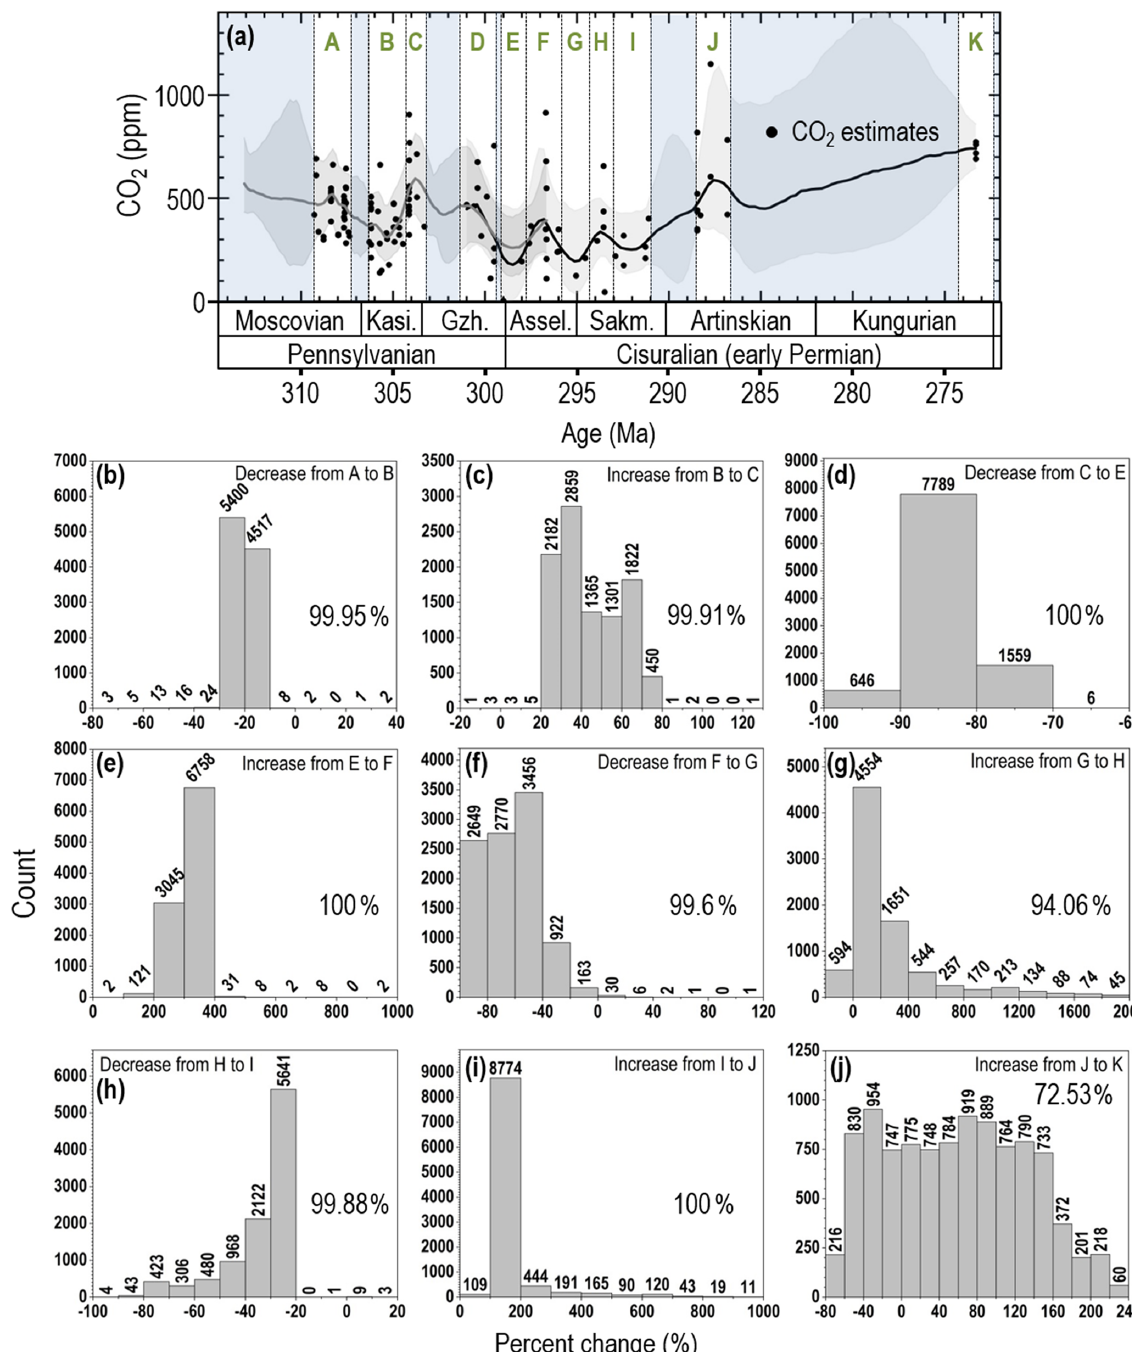
Figure 4. Analysis of the statistical significance of short-term CO 2 fluctuations. (a) White intervals (A–K) delineate short-term highs or lows in the CO 2 LOESS trend used for binning ( n = 11; bins ± 0 . 5 to 1Myr resolution). Raw stomatal-based and pedogenic carbonate-based CO 2 estimates generated by Monte Carlo analysis (10000 model runs per CO 2 estimate; data in shaded intervals were not used). CO 2 between bins was compared by calculating the mean of the lowest through to the 10000th (highest) Monte Carlo values for all CO 2 points in each bin and comparing the means of the two bins sequentially. (b–h) Histograms of the percent change between each of the 10000 Monte Carlo means of the adjacent bins. Negative values indicate a decrease in value between bins and positive values an increase. The number above each histogram bar is the “percent change” values represented in each bar. The percent of the 10000 model runs that confirm a given increase or decrease in the LOESS trend is indicated by the % value shown on the right side of each panel. See Sect. 2 for further